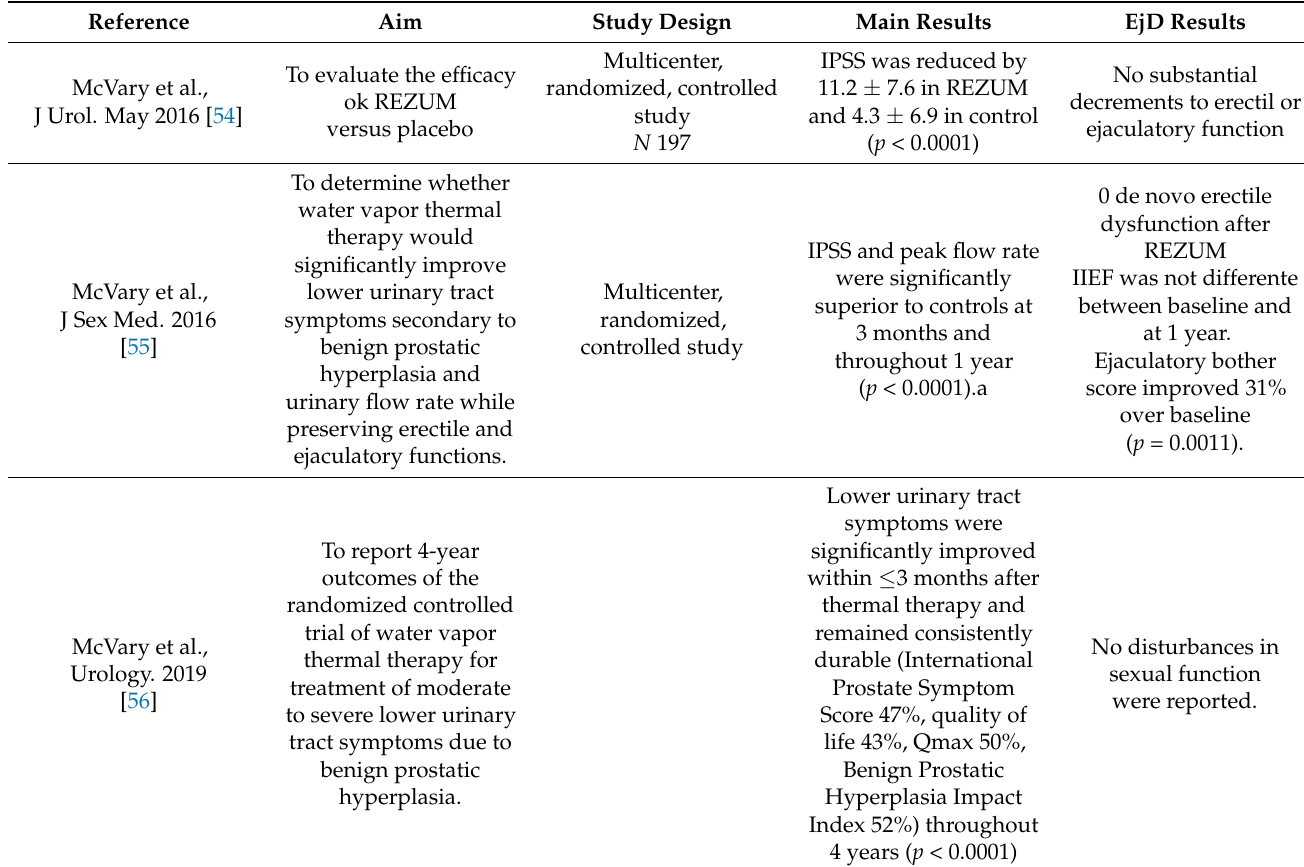
Table 9. Impact of Rezum procedure on the ejaculatory